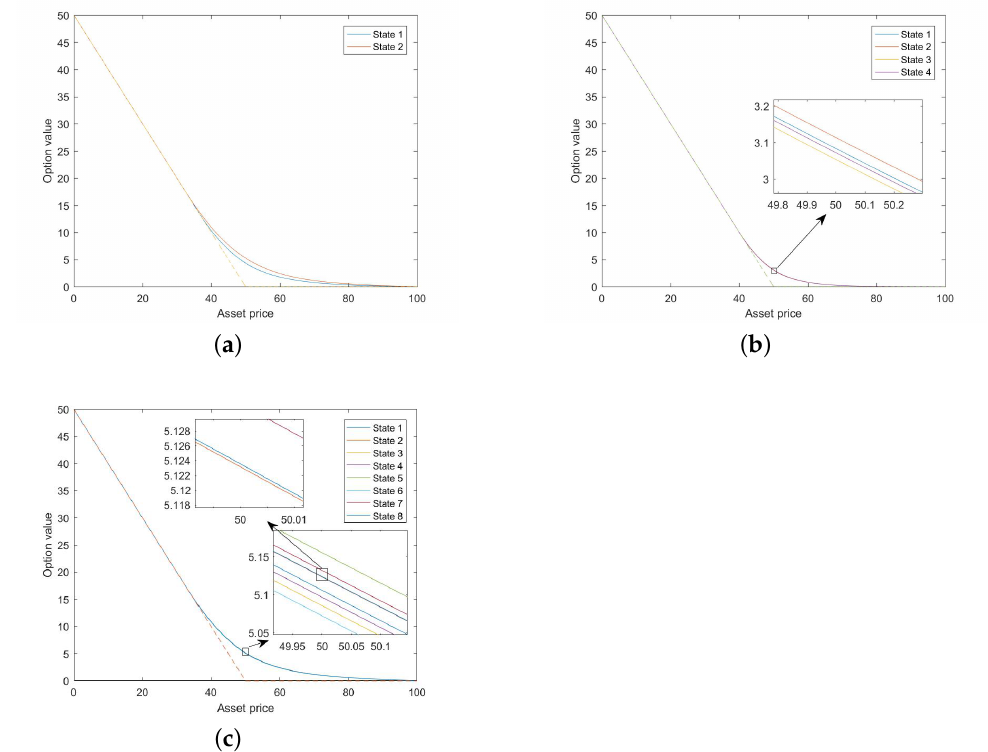
Figure 3. Option value of three examples: ( a ) option value of two regimes; ( b ) option value of four regimes; ( c ) option value of eight